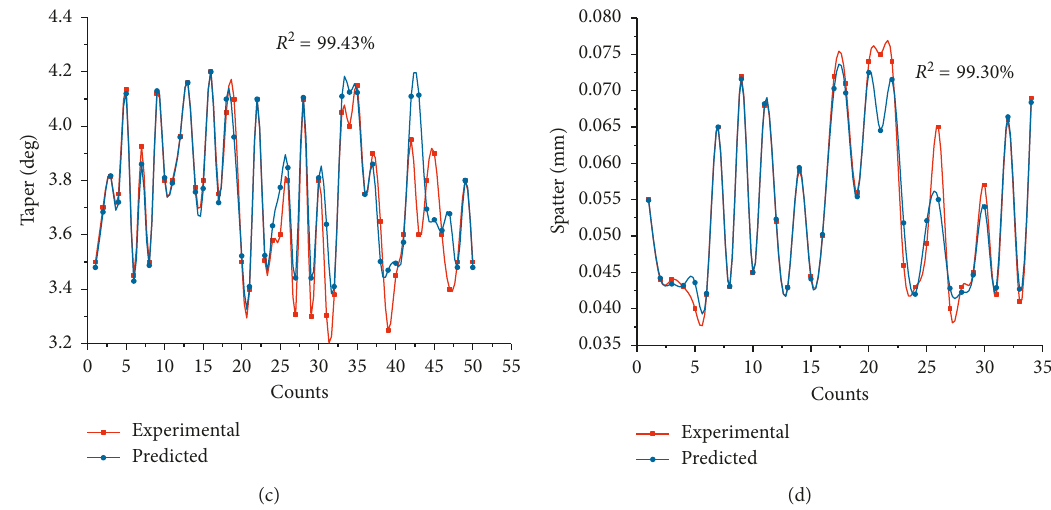
Figure 2: Regression fit for the percentage of microdrilling process parameters of the MMCs. (a) Experimental-predicted value of cir- cularity. (b) Experimental-predicted value of HAZ. (c) Experimental-predicted value of taper. (d) Experimental-predicted value of spatter.